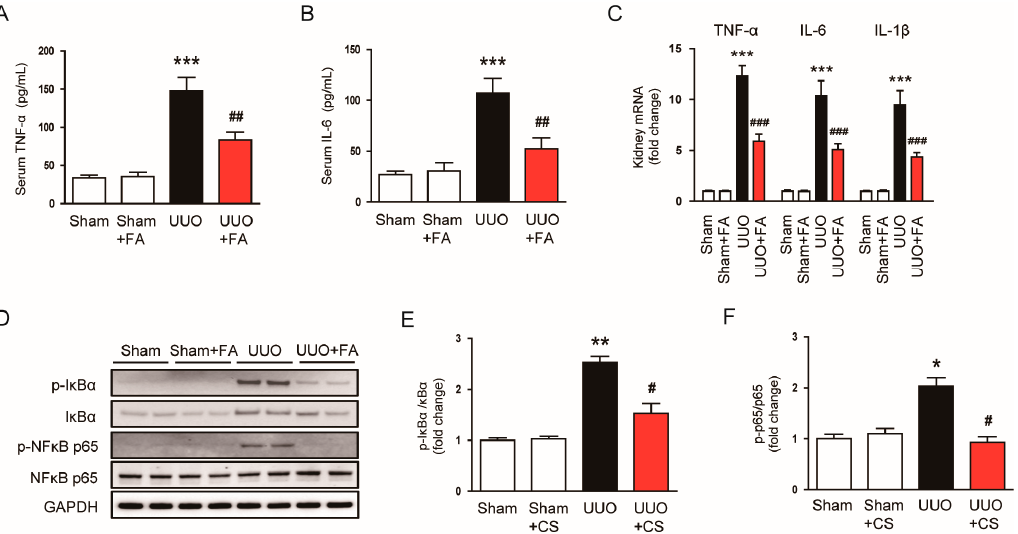
Figure 9. Effects of FA on cytokine production in UUO mice. ( A ) Serum TNF- α and IL-6 levels. ( B ) Renal TNF- α , IL-6, and IL-1 β mRNA levels. ( C ) Western blotting of p-I κ B- α and p-NF κ B p65. ( E ) Quantification of Western blots for p-I κ B- α . ( F ) Quantification of Western blots for p-NF κ B p65. * p < 0.05, ** p < 0.01 and *** p < 0.001 vs. Sham. # p < 0.05, ## p < 0.01 and ### p < 0.001 vs. UUO.